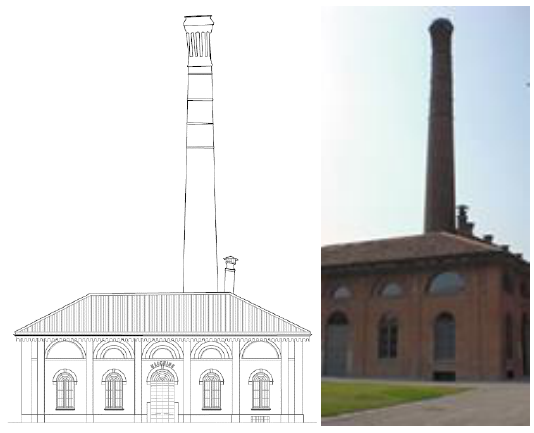
Figure 1. The chimney in the C. Guidotti pavilion of the former municipal slaughterhouse of Piacenza.